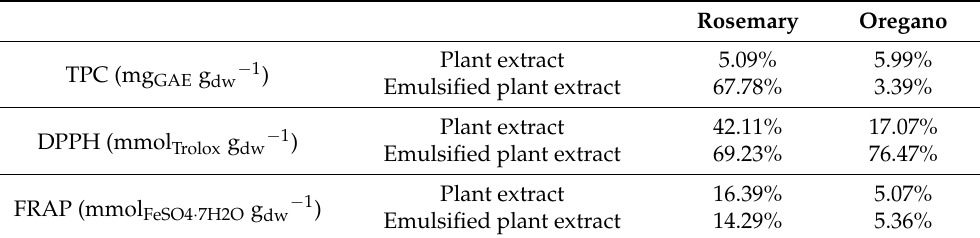
Table 6. Bioavailability of total polyphenols from rosemary/oregano extracts and oil-in-water emul- sions containing rosemary/oregano extract after in vitro digestion, with the addition of commercial pea protein as